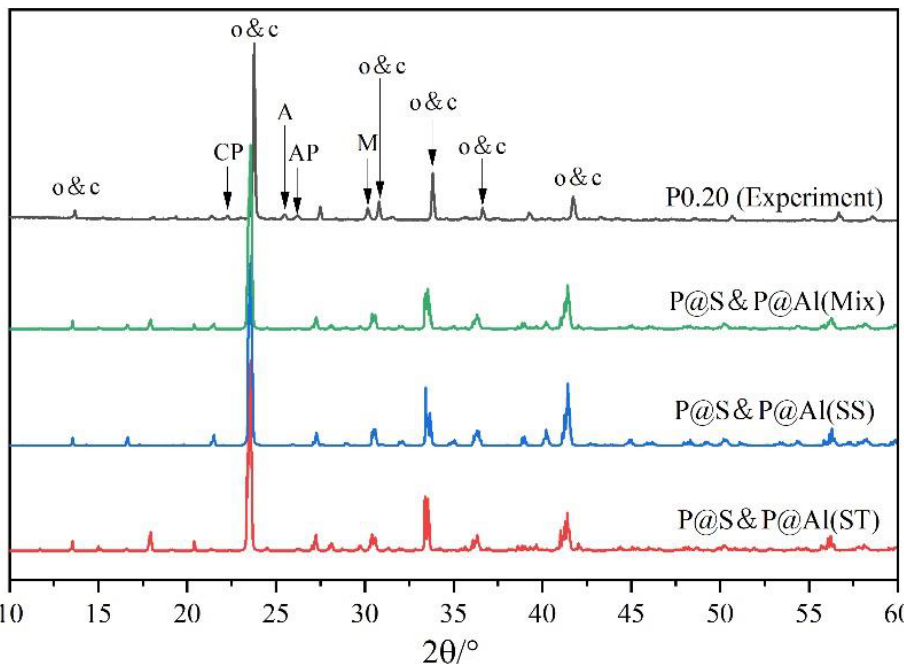
Figure 13. Comparison of experimental and simulated XRD patterns.